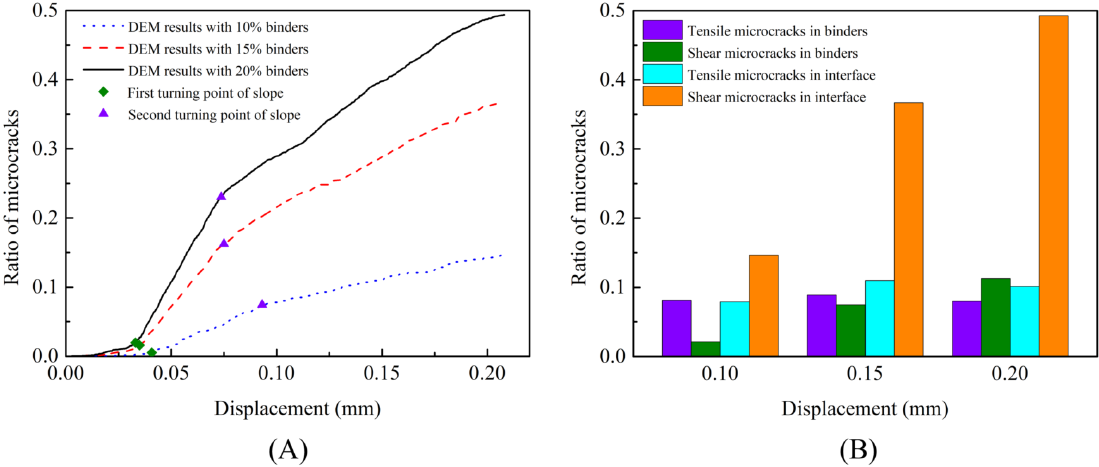
12 Figure 12. ( A ) Propagation of shear microcracks at the interfaces; ( B ) ratio of the number of different types of microcrack to the number of corresponding bonds in the final state.